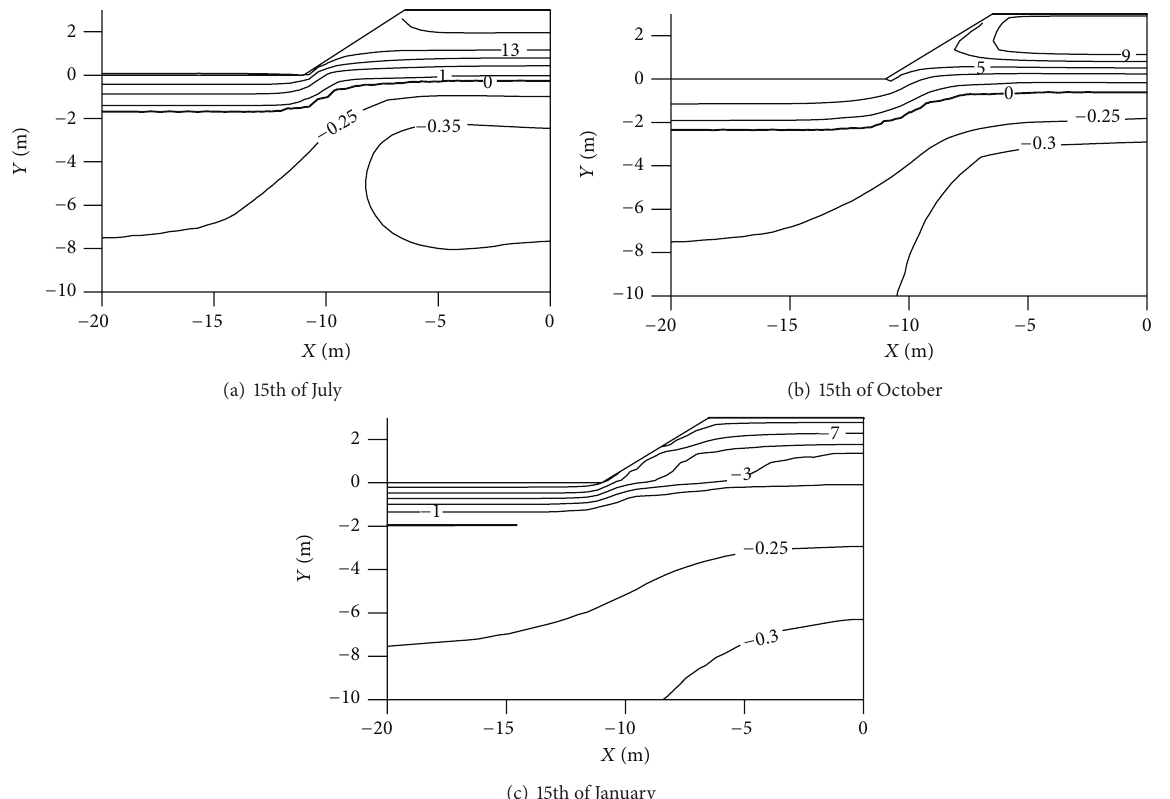
Figure 7: Temperature field of the closed crushed-rocks embankment with the narrow pavement after 50 years of